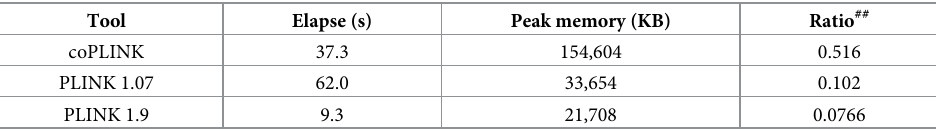
Table 4. Average elapsed time and peak memory # .